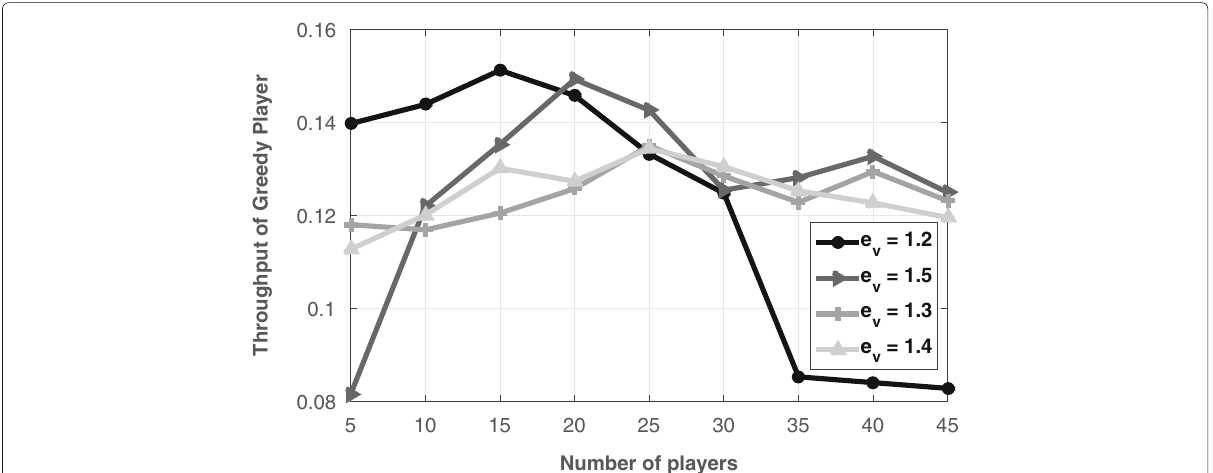
Fig. 4 Effect of a vigilante player’s aggression coefficient, e v , on the throughput of a moving greedy